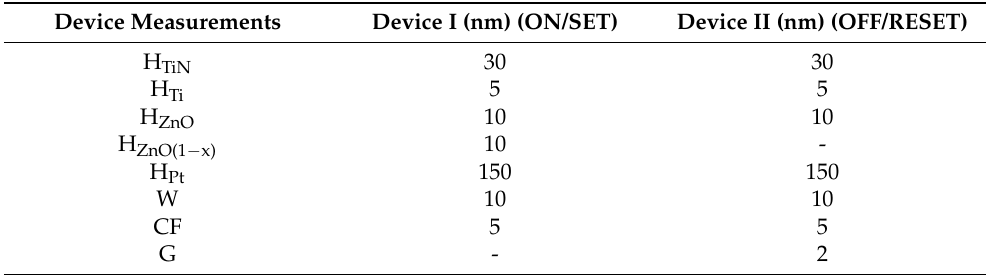
Table 2. Dimensions of the